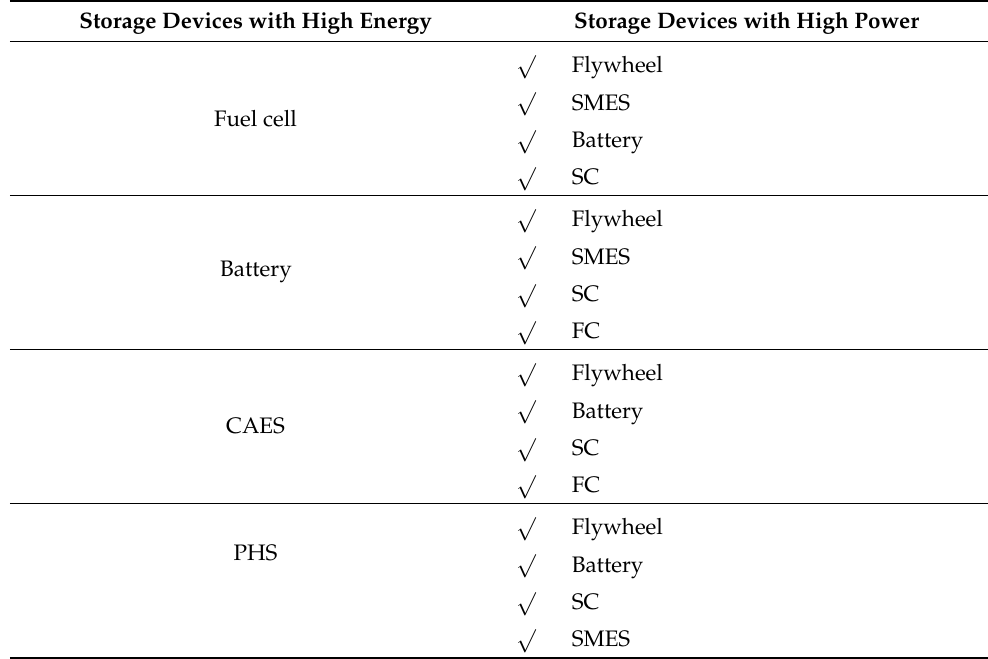
Table 3. Possible chart of HESS configurations